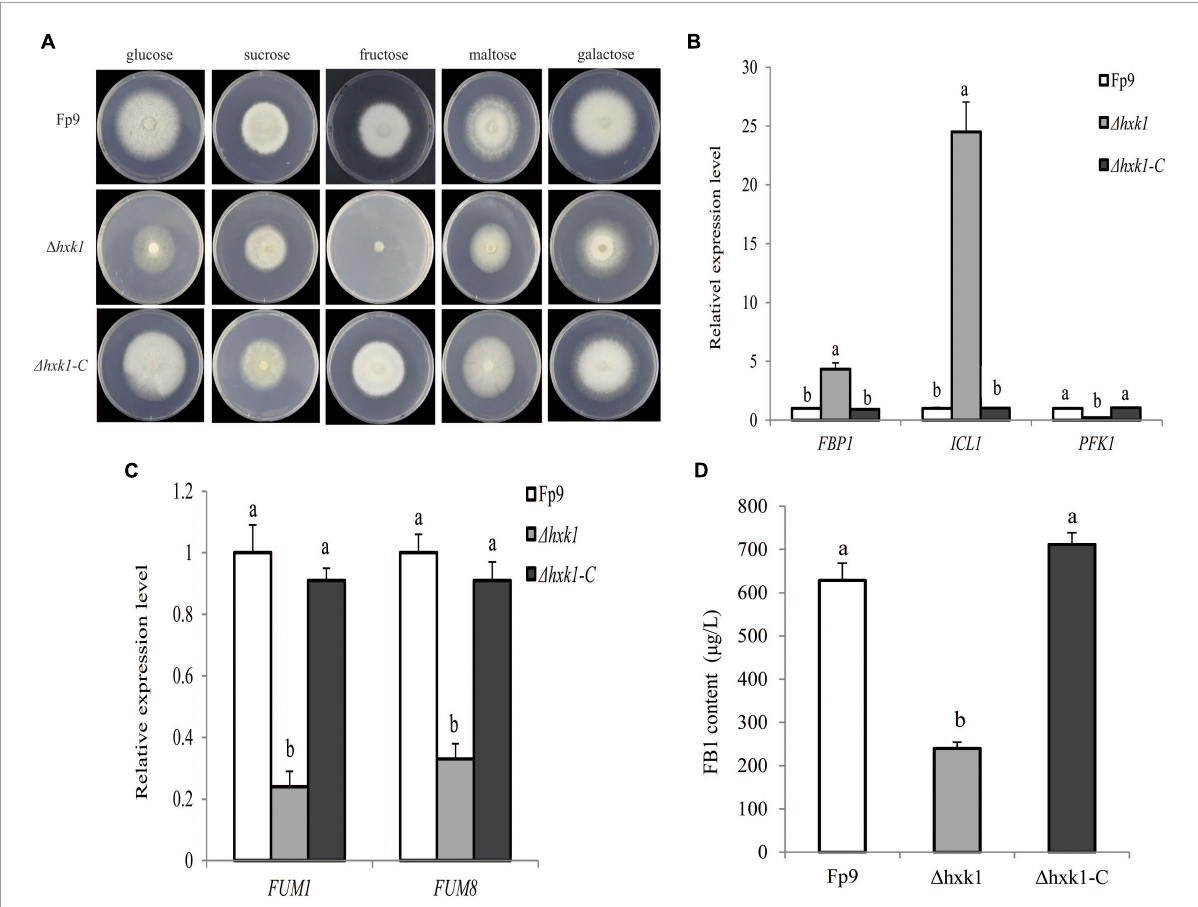
FIGURE8 Defects of (cid:49) hxk1 mutant in fructose assimilation and FB1 production. (A) Five-day-old colonies of (cid:49) hxk1 mutant grown on minimal media (MM) containing glucose, sucrose, fructose, maltose and galactose as the sole carbon source at 55 mM concentration, respectively. (B) The expression levels of FBP1 encoding fructose-1,6-biophosphatas, ICL1 encoding isocitrate lyase and PFK1 encoding phosphofructokinase of (cid:49) hxk1 grown in YEPD media for 72 h before switching to DL cultures for 3 h. Its relative expression level in wild-type strain Fp9 was arbitrarily set to 1. Different letters on bars indicated a significant difference ( p < 0.05) with three biological replicates. (C) The expression levels of FUM1 and FUM8 encoding aminotransferase of (cid:49) hxk1 grown in YEPD media for 72 h before switching to DL cultures for 48 h, respectively. Its relative expression level in wild-type strain Fp9 was arbitrarily set to 1. (D) FB1 production of (cid:49) hxk1 grown in YEPD media for 72 h before switching to DL cultures for 7